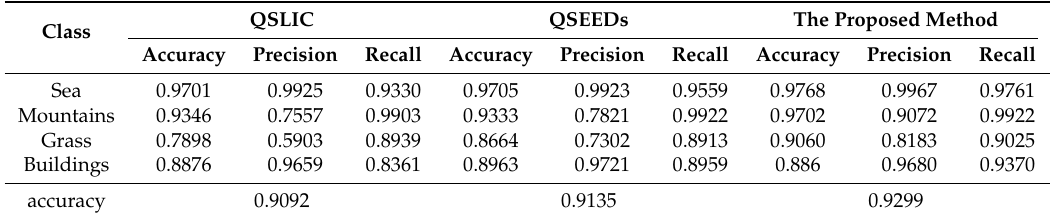
Table 2. The accuracy, precision and recall for San Francisco data